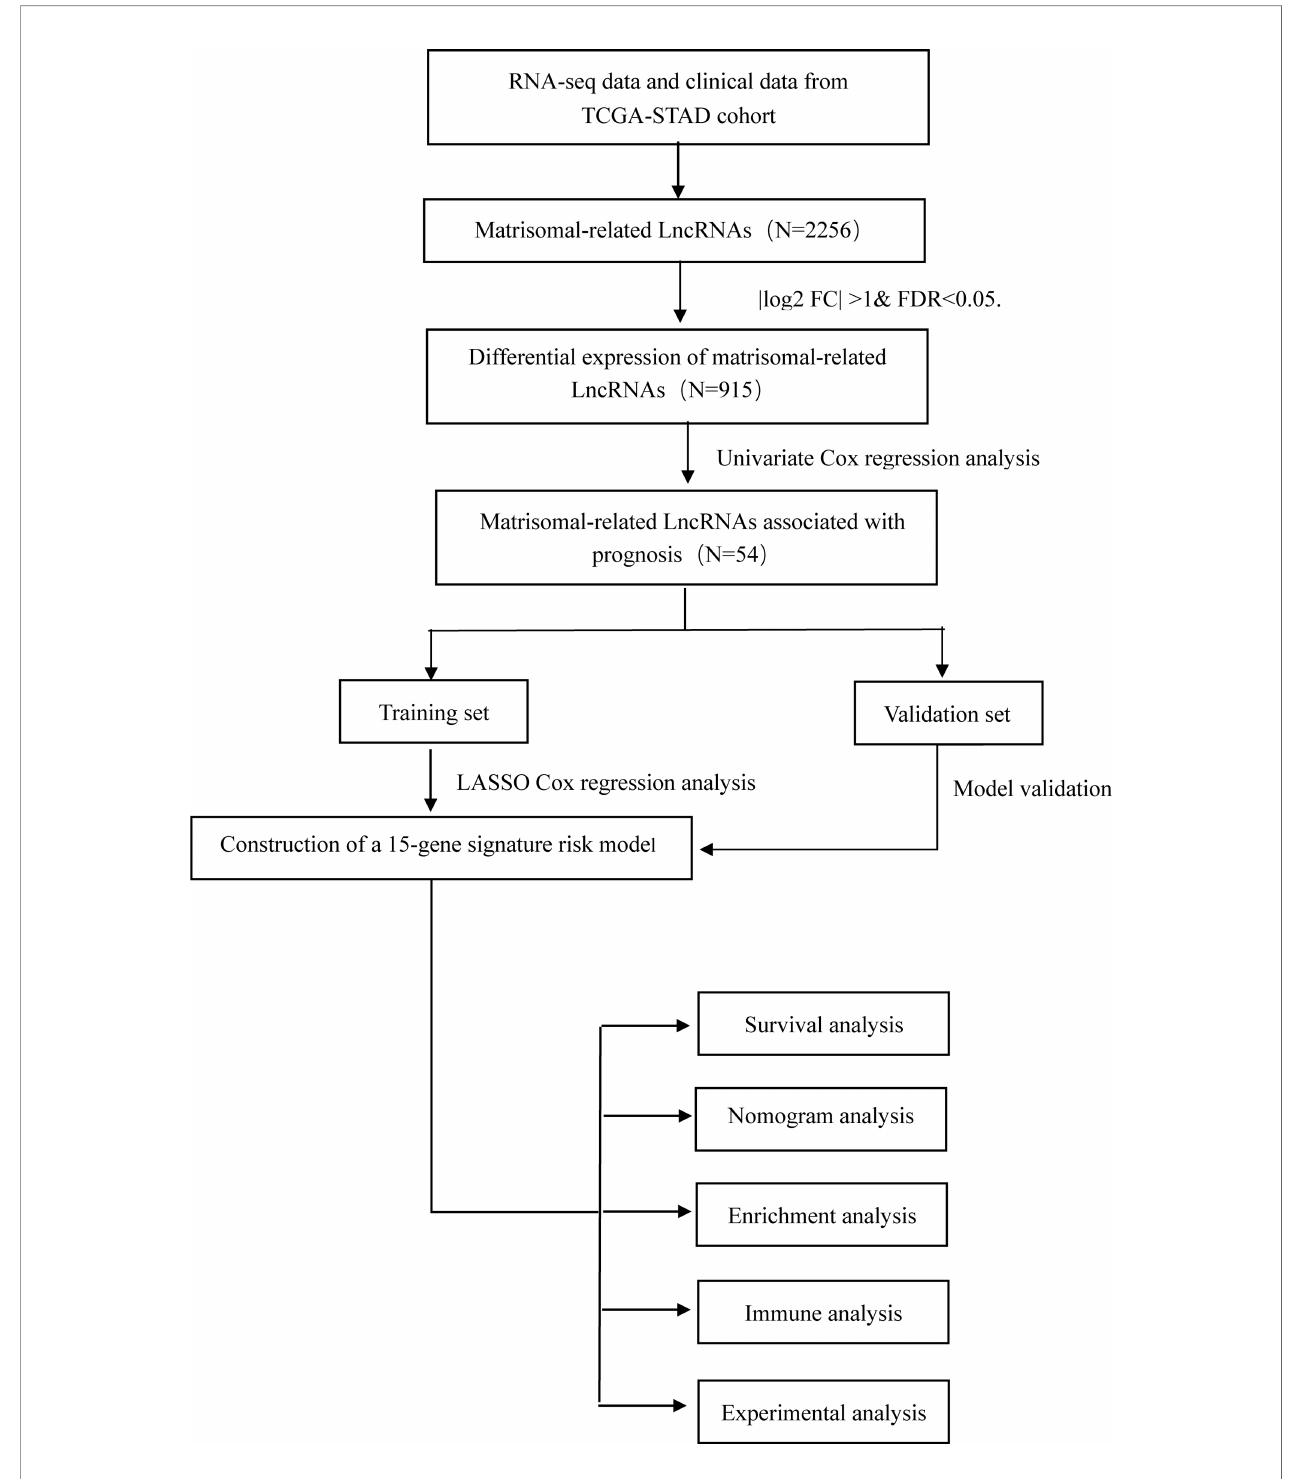
FIGURE 1 | The fl owchart of this